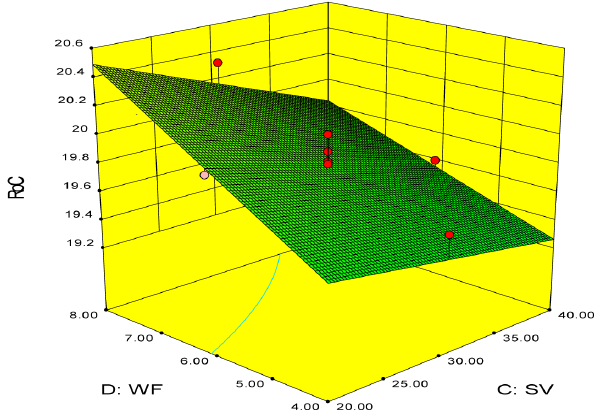
Figure 8b. Combined e ff ects of SV and WF on RoC.